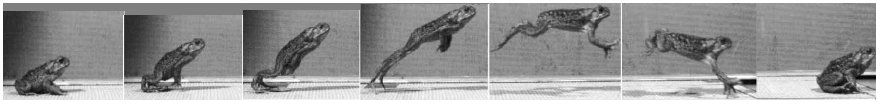
Figure 1. The frog jumping process